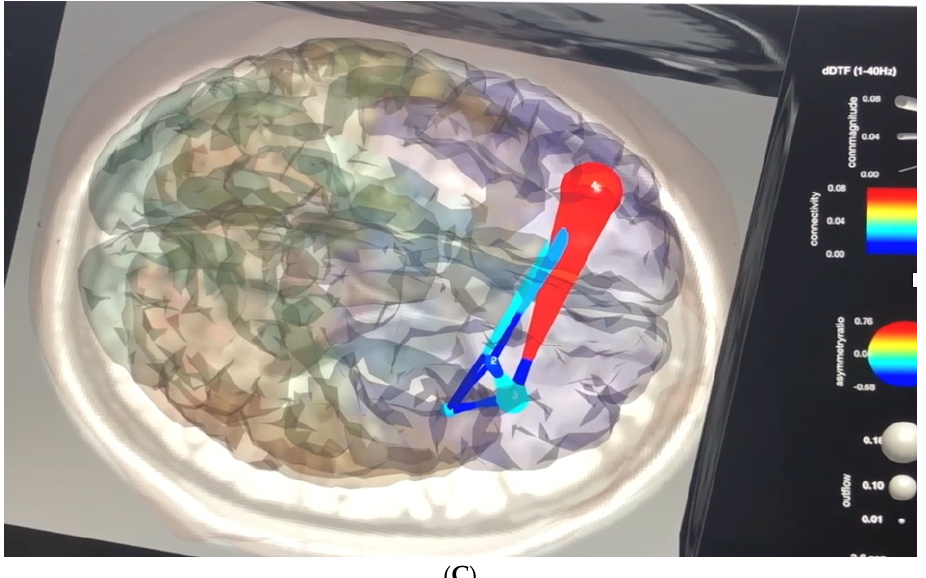
Figure 1. Pre-implant condition. ( A ) 3D oral scanner study. Points of dental inter arch pressure by color-coded depiction (red as maximum altered dental pressure, green as minimal) show several spots of dental abnormal pressure. ( B ) Representation of the frontal-parietal current density dipole field estimated by the low-resolution brain electrographic tomography (LORETA). Red color indicates maximum current density while deep blue coded the minimum, shows a strong asymmetry between the distribution field of the left frontal-parietal areas. ( C ) Granger causality for four component dipoles localized to the right, left frontal gyrus and the temporal–parietal regions. Dimensions of blue circles and thin lines indicates lower causality, while red indicate high causality. Causality image at baseline occurring at 6310 of 8000 ms of EEG recording. The effective connectivity (high causality) was depicted by the color-coded (full red circle) asymmetry index with the right dominant frontal-parietal hub and by the red color of the direction of the edge originating from these areas.